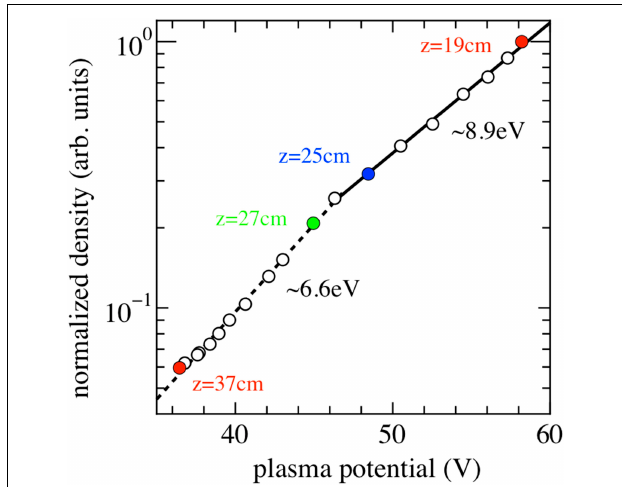
FIGURE 4 | “Boltzmann” plot of normalized density vs. plasma potential showing trapped electrons ( z = 19–25cm, solid line) with a temperature of 8.9eV and free electrons ( z = 25–37cm, dotted line) with a temperature of